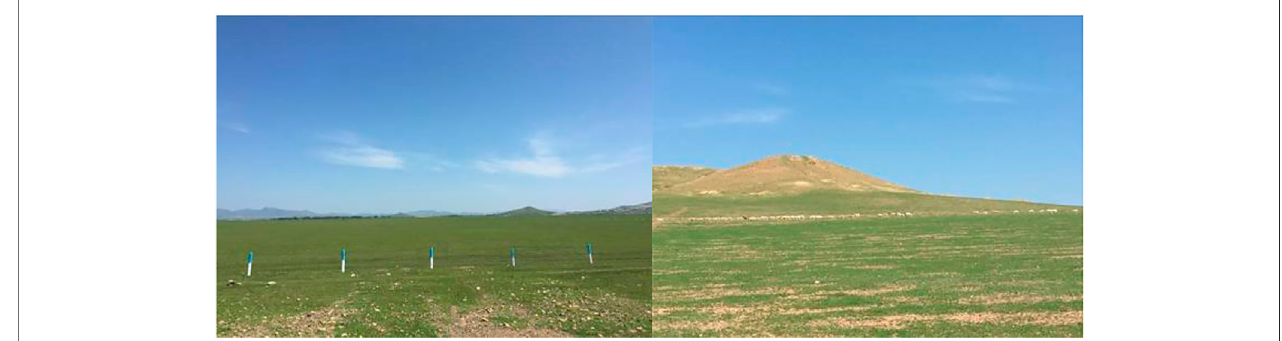
FIGURE 5 | Grassland in wuriduhubu (left) and haolibao (right) in August 2016.